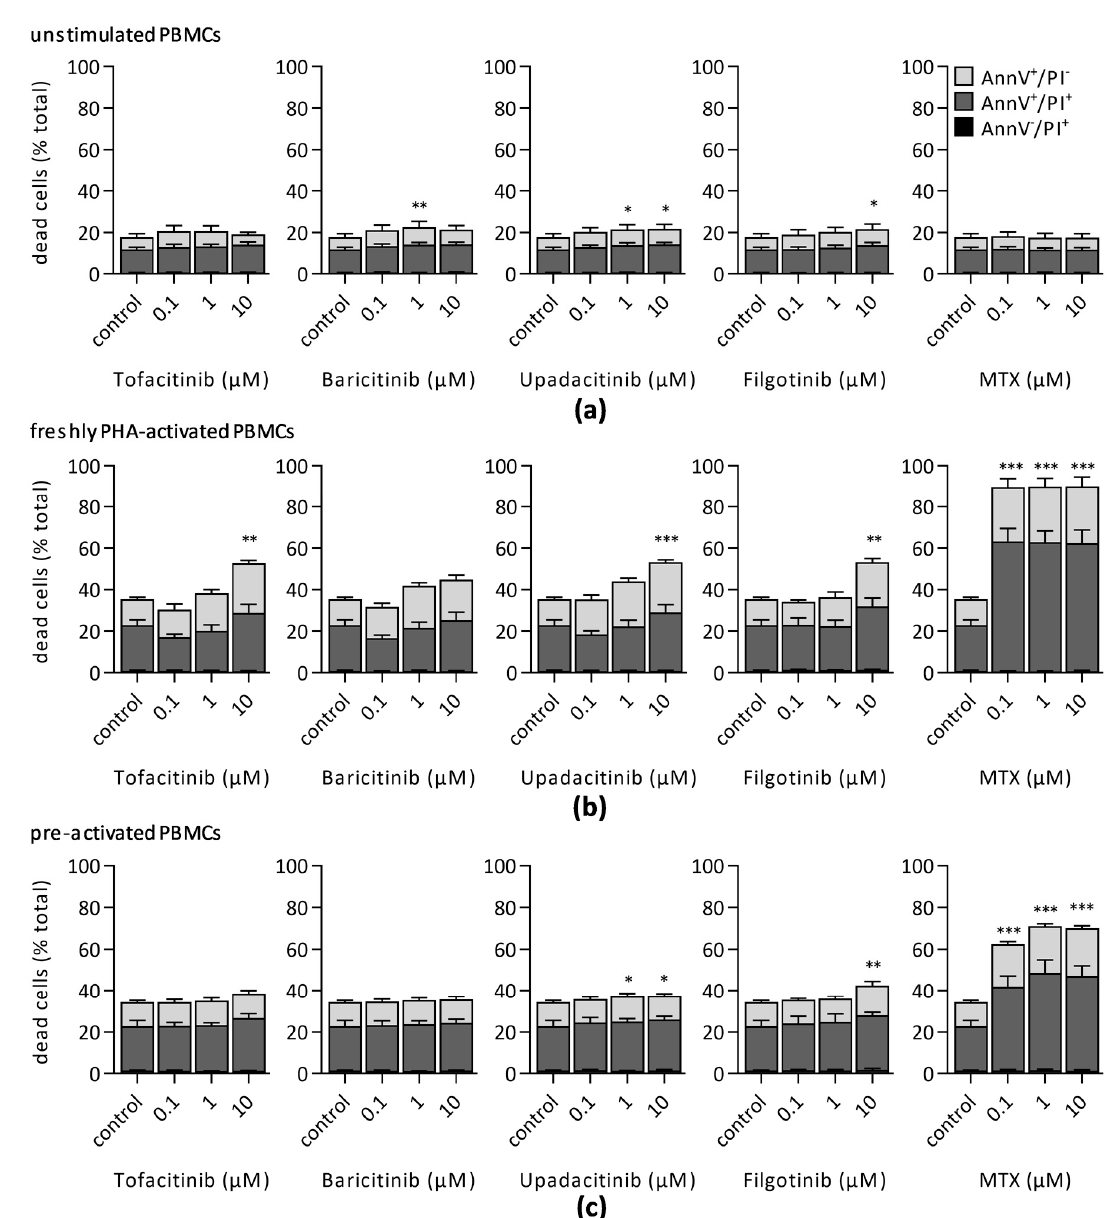
Figure 4. Cell viability was assessed after 72 h by Annexin V/PI staining of ( a ) unstimulated, ( b ) freshly PHA-stimulated, or ( c ) preactivated PBMCs treatment with indicated concentrations of JAKi or MTX. Percentage of Annexin V + /PI − (light grey), Annexin V + /PI + (dark grey), and Annexin V − /PI + (black; <2%) population were quantified. Diagrams display the mean ± SEM of five independent experiments (*** p ≤ 0.001; ** p ≤ 0.01; * p ≤ 0.05).